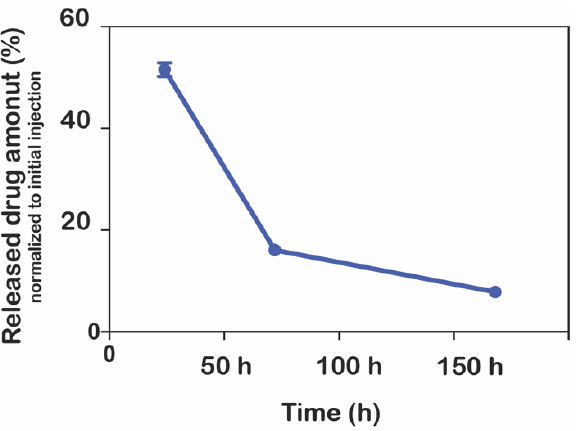
Figure 6. In vivo release profile of nanofiber gel [ranibizumab]:[PA]; 1:1. There was no detectable ranibizumab on day 7 in the control groups.